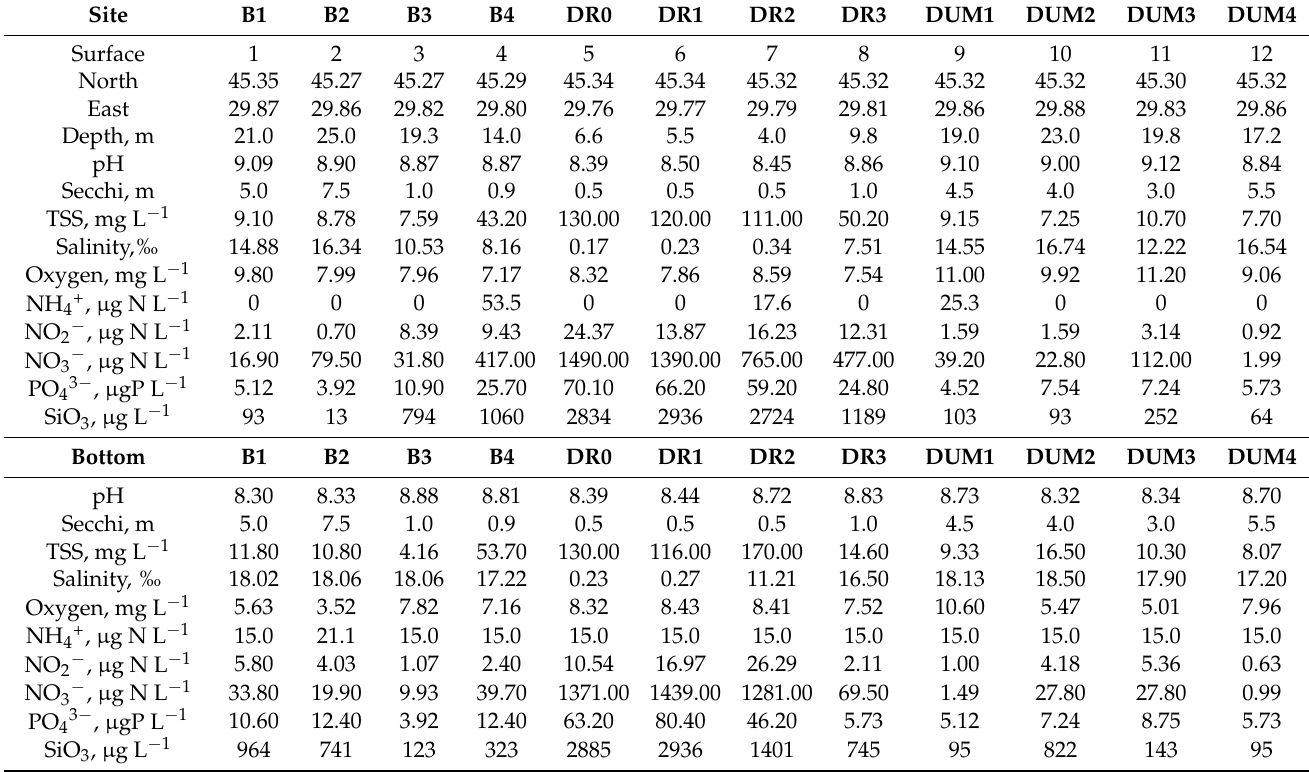
Table A1. Hydrochemical parameters in the Ukrainian part of Danube nearshore area in August